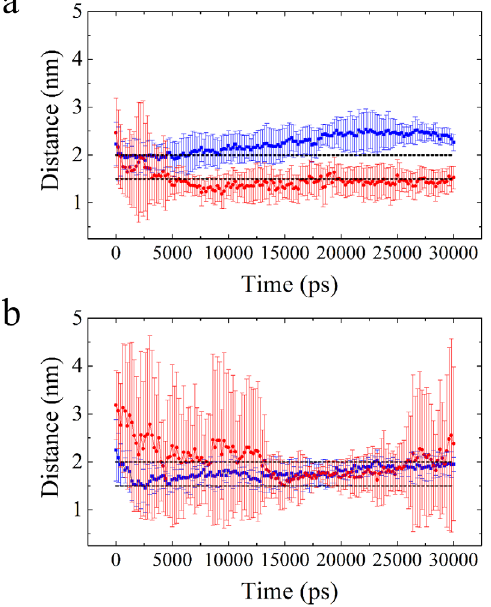
Figure 6. Representative energy landscapes. These are construct- ed by taking the interaction of a single caffeine and a single tetracaine molecule with each lipid of the upper membrane surface (an array of 10 6 10 lipids). Each landscape shows the morphology of the deepest potential well of the drug/membrane system simulation. (a) Coulomb potential for caffeine. (b) Lennard-Jones potential for caffeine. (c) Coulomb potential for tetracaine. (d) Lennard-Jones potential for tetracaine. The scales in the X–Y planes are in lipid units ( * 0 : 8 nm).